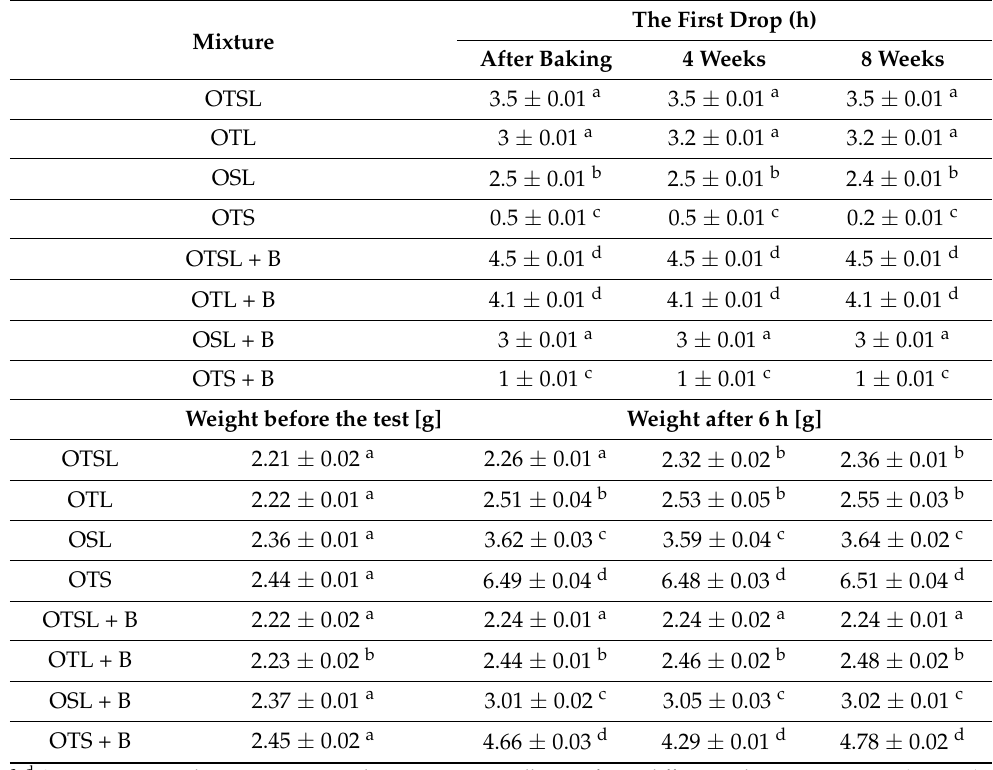
Table 5. Occurrence of first drop and water absorption by the package.